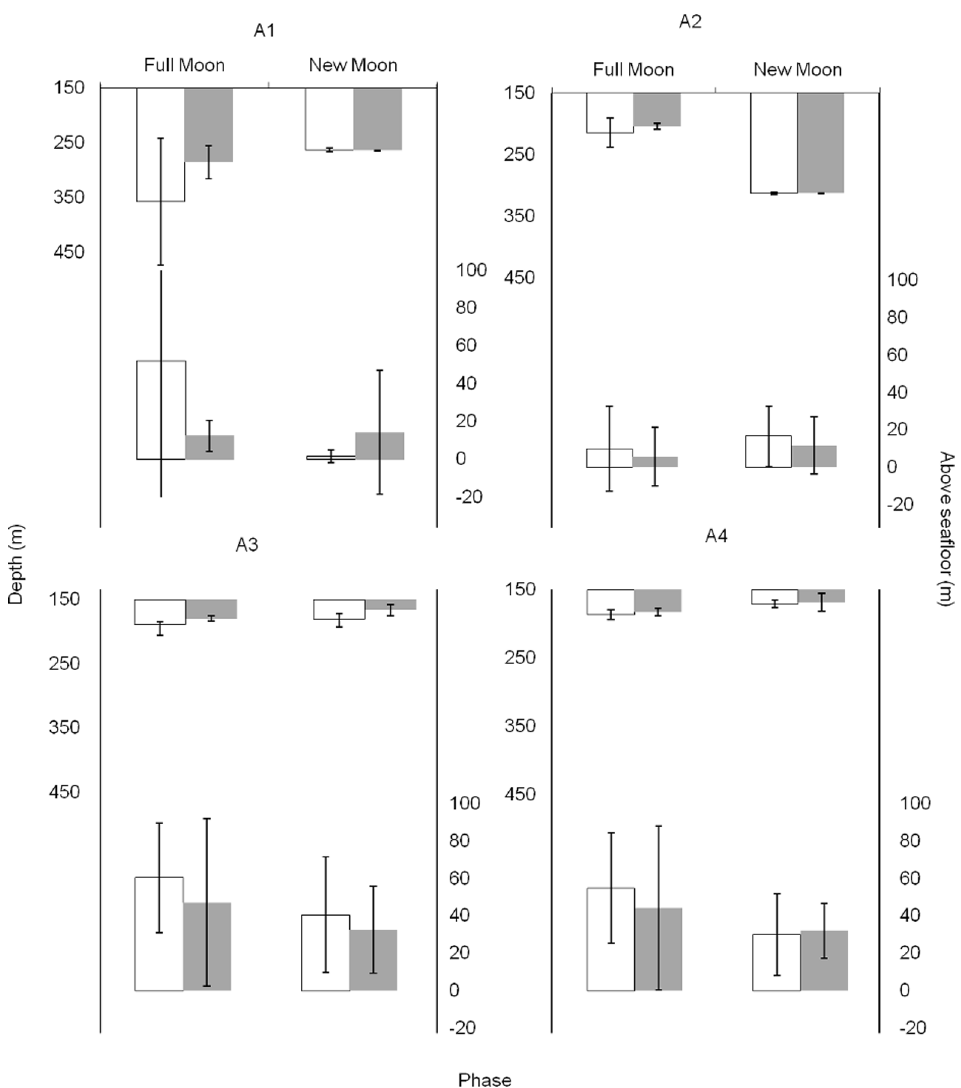
Figure 2. Active telemetry: vertical behaviour from versus moon and diel phase. The average ( 6 95% confidence interval) depth (upper portion of graphs) and distance above seafloor (lower portion of graphs) of the four individuals actively tracked across the Condor seamount is shown between each lunar period (full moon vs. new moon) and time of day (day/white vs. night/grey).